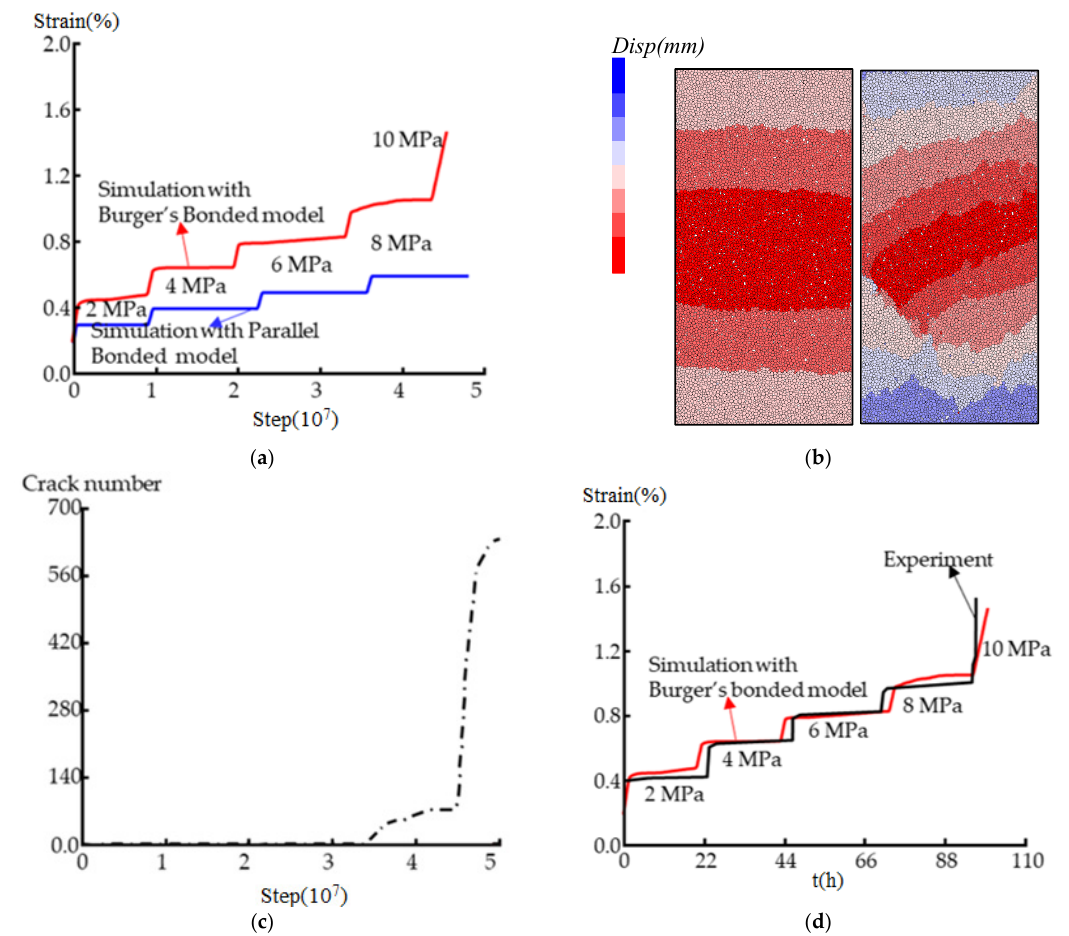
Figure 7. The creep curves and creep mechanisms. ( a ) The strain curves of PBM and BBM; ( b ) the grain’s deformation comparison between PBM and BBM. ( c ) The crack numbers during simulation process using BBM. ( d ) The comparison of creep curves between experiment and simulation.